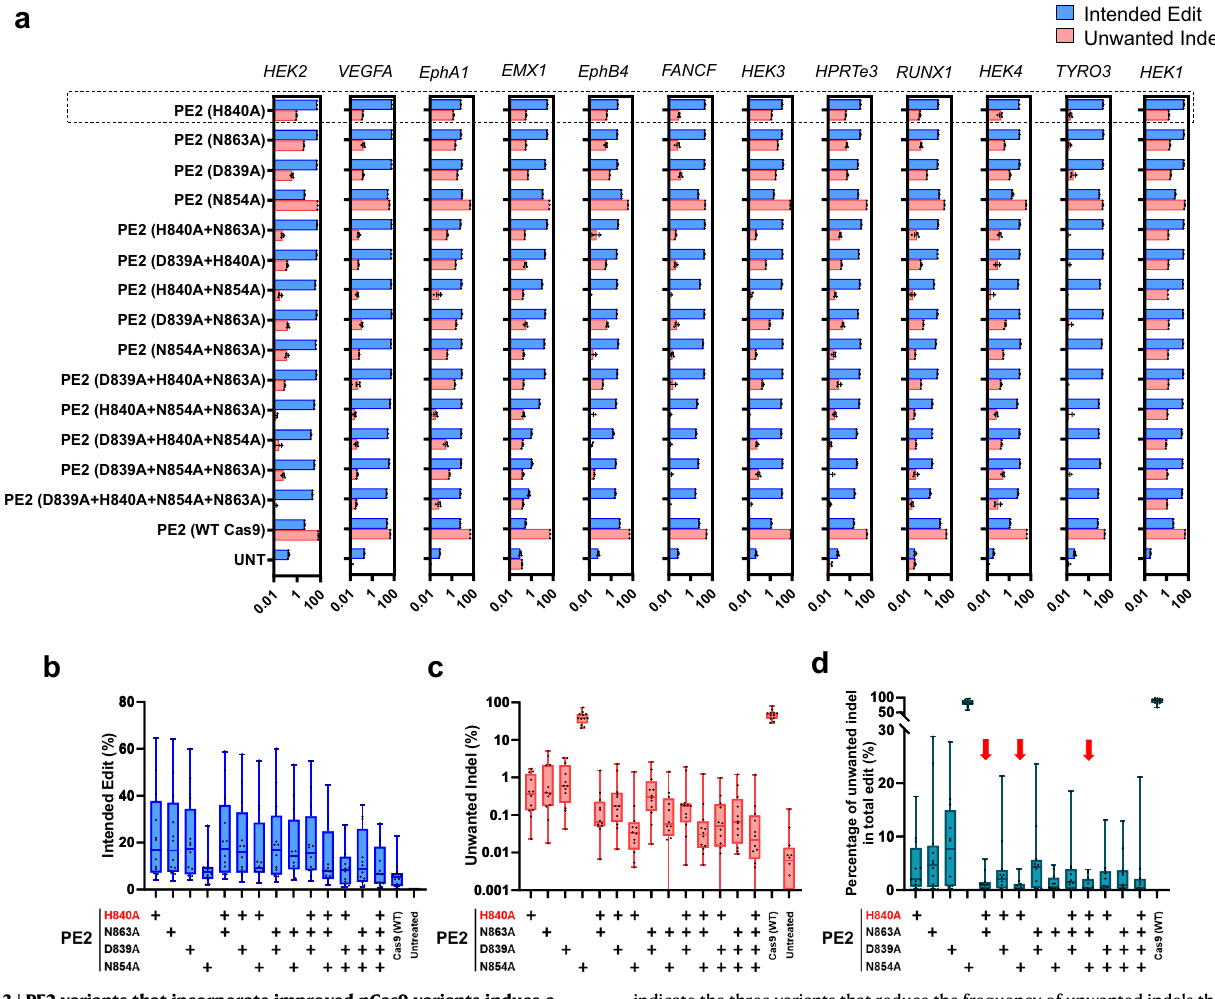
indicate the three variants thatreduce the frequencyof unwanted indels the most, relative to all edited sequences. Mean±SEM ( a ) were determined three indepen- dent experiments. Mean±SEM ( b – d ) of all individual values of sets of n =3